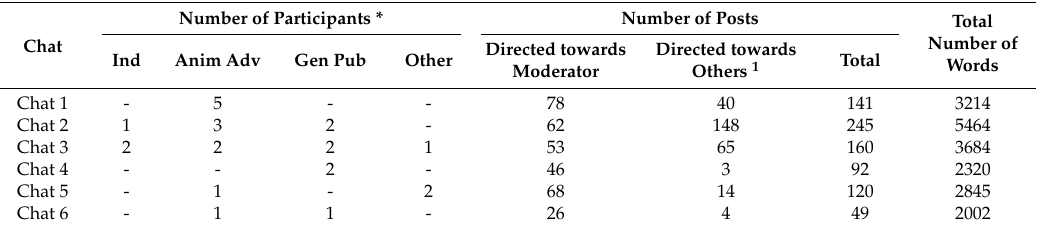
Table 3. Group composition, number of posts, and number of words per